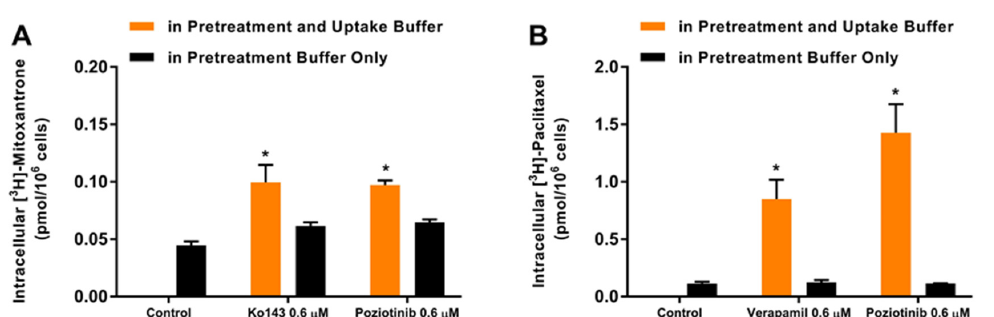
Figure 8. Poziotinib reversibly inhibits the efflux function of the ABCG2 and ABCB1 transporters. ( A ) The intracellular accumulation of [ 3 H]-mitoxantrone in S1-M1-80 colon cancer cells after 2 h of preincubation with either vehicle (Control), Ko143 or poziotinib ( B ) The intracellular accumulation of [ 3 H]-paclitaxel in SW620/Ad300 colon cancer after 2 h of preincubation with either vehicle (Control), verapamil or poziotinib. Ko143 was used as a positive control for inhibition of the ABCG2 transporter and verapamil was used as a positive control for inhibition of the ABCB1 transporter. Data are expressed as the mean ±SD based on three independent experiments. * p < 0.05 versus the control group.